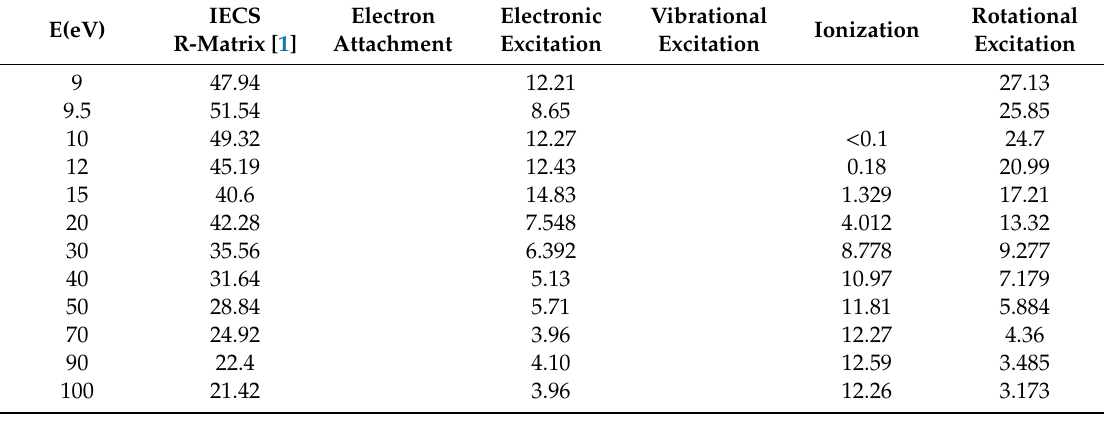
7 of 19 energies reaching a maximum discrepancy of about 50% around 1 eV. The origin of this discrepancy